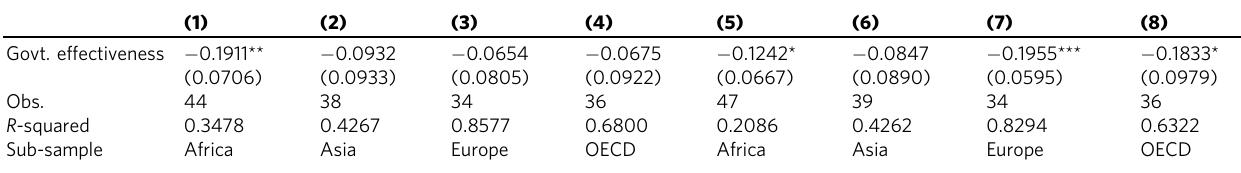
Table 10 Relationship between government effectiveness and the COVID-19 growth rate: sub-sample analysis.